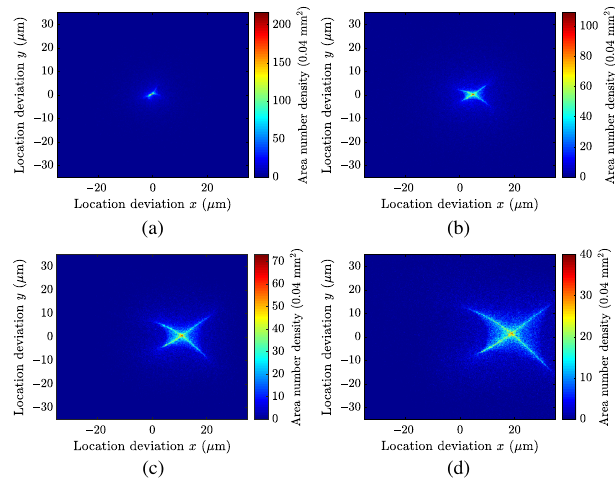
FIG. 9. Beam profiles of transported protons at the center of the LIGHT beamline (2.5 m from its origin). The magnetic field of the solenoid was thereby generated by the wire geometry shown in Figs. 3(e) and 3(f). The deviations of these four beam profiles are due to a different angle α between the x - y plane and the connecting cables. (a) α ¼ 90 °, (b) α ¼ 75 °, (c) α ¼ 60 °, and (d) α ¼ 45